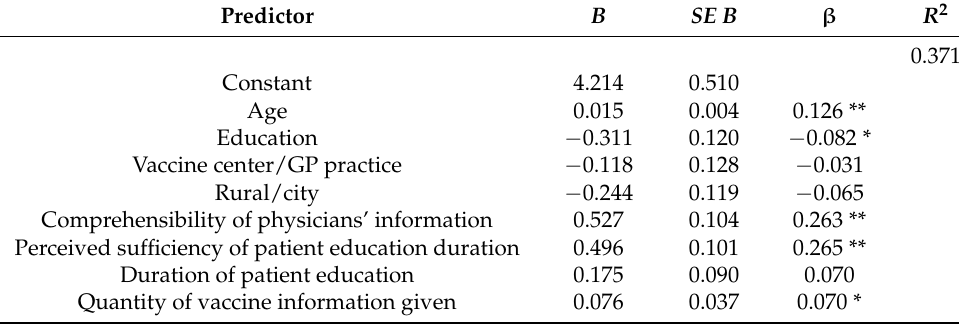
Table 4. Multiple regression analysis predicting satisfaction with patient